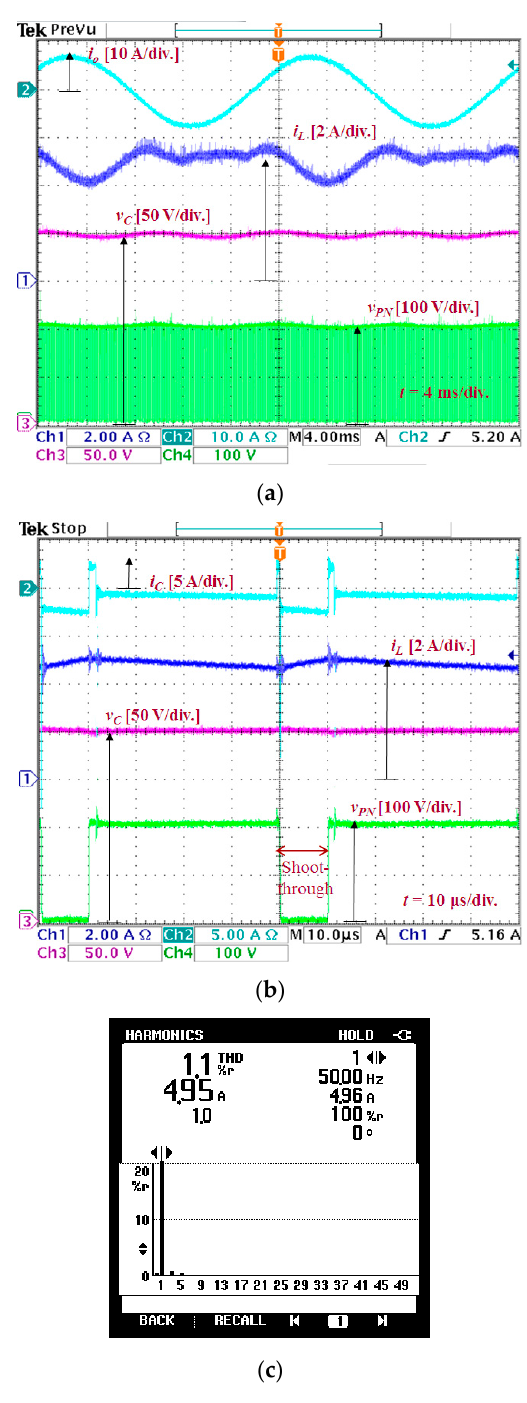
Figure 9. Experimental waveforms for qSBI when V dc = 120 V, M = 0.8 and A = 0.01. From top to bottom: ( a ) load current, inductor current, capacitor voltage, DC-link voltage; ( b ) capacitor current, capacitor voltage, inductor current, DC-link voltage; and ( c ) load current harmonics.